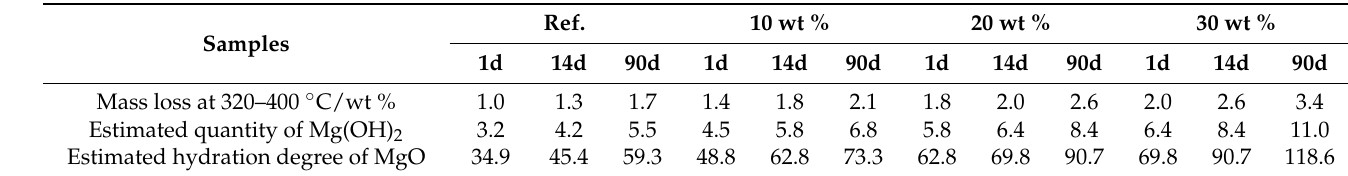
Table 3. Estimated quantity of Mg(OH) 2 and hydration degree of